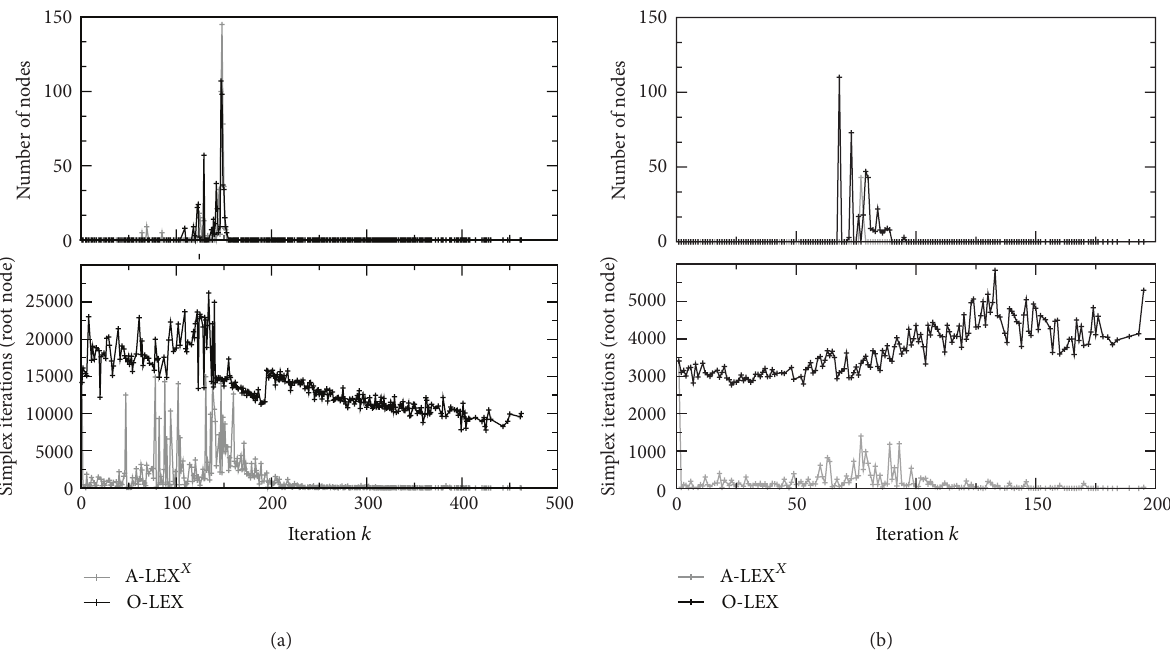
Figure 4: The number of nodes processed by the branch-and-bound method and the number of simplex iterations needed to process the root node as a function of the iteration step 𝑘 . The results were obtained for the benchmark 𝑆𝐽𝐶4 in (a) 𝑝 = 20 and in (b) 𝑝 = 80 . purpose IP solver by the customized 𝑝 -median solver.